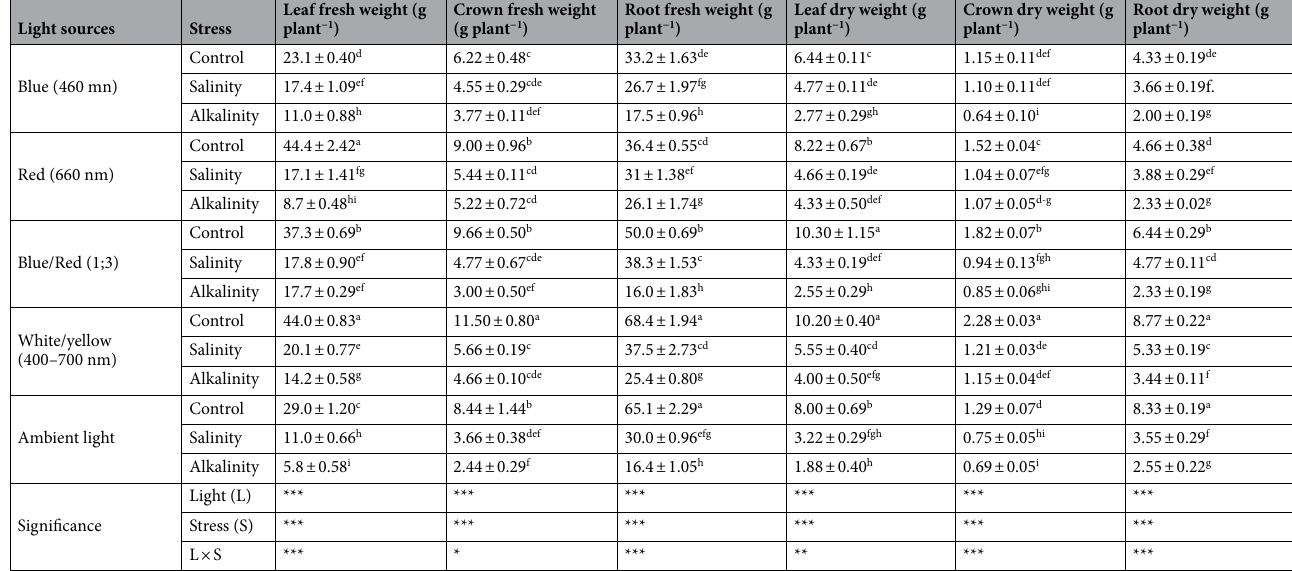
Table 3. Interaction of light sources and stress (salinity and alkalinity) on vegetative characteristics of strawberry cv. Camarosa. Values are means ± SE of three replicates. Bars with different letters show significant differences at P ≤ 0.05 (Duncan). Significance according to ANOVA, ns, *, **, ***, no significant and significant P ≤ 0.05, 0.01, 0.001, respectively. Control (no stress), salinity (80 mM NaCl) and alkalinity (40 mM NaHCO 3